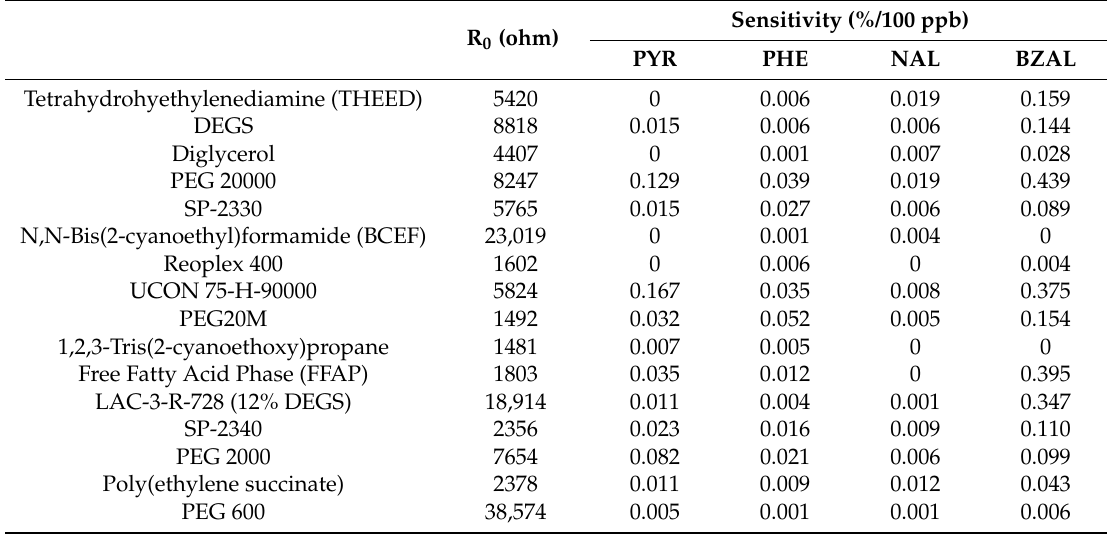
Table 5. Summary of the experimental evaluation of the fabricated 16-channel chemosensitive resistor